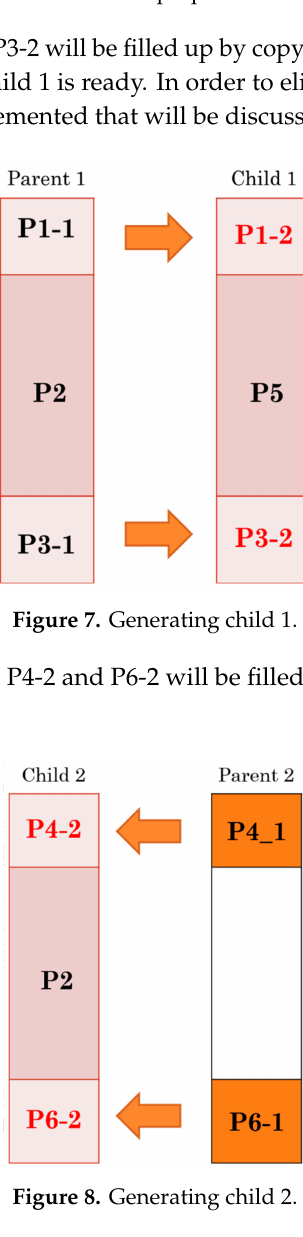
Figure 6. Basic idea of proposed architecture.